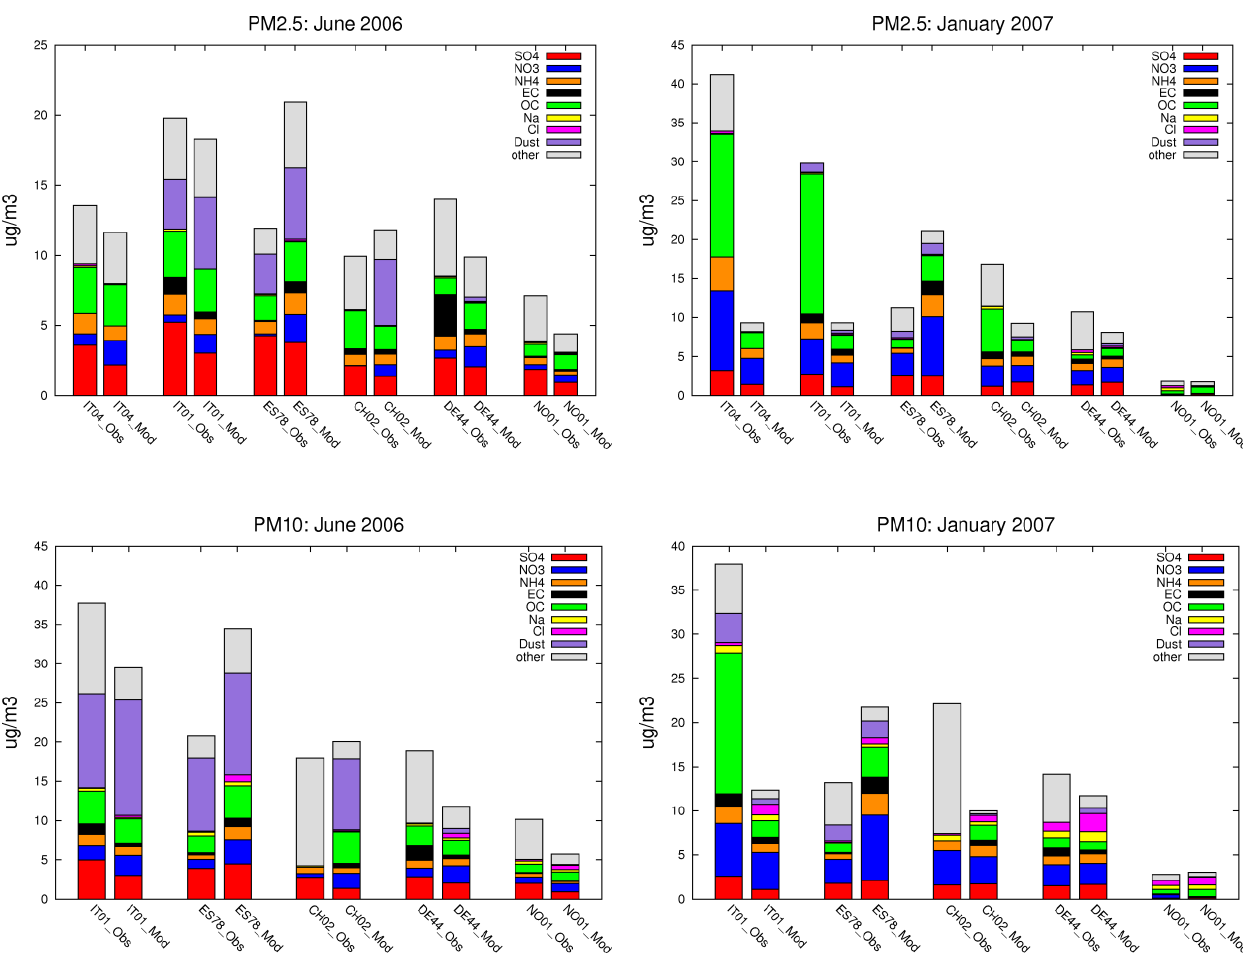
Fig. 5. Observed and modelled chemical composition of PM 10 (bottom) and PM 2 . 5 (top) for June 2006 (left) and January 2007 (right), from observations and model results. “Other” denotes not determined PM mass in measurements, and particle water + missing carbonaceous matter (OM-OC) in calculations. Note: (1) Full mineral composition was measured only at IT01 and ES17, (2) Very few days (1–6) with data at ES1778, besides different coverage for different components; (3) measured PM 2 . 5 speciation at CH02 is based on daily SIA in PM 1 and hourly EC/OC in PM 2 . 5 data; (4) measured nitrate and ammonium in PM 10 at NO01 in January 2007 are from